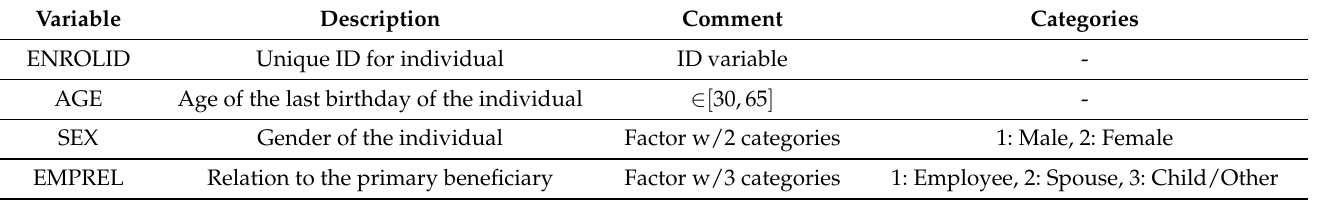
Table 1. Description of variables in the admission data